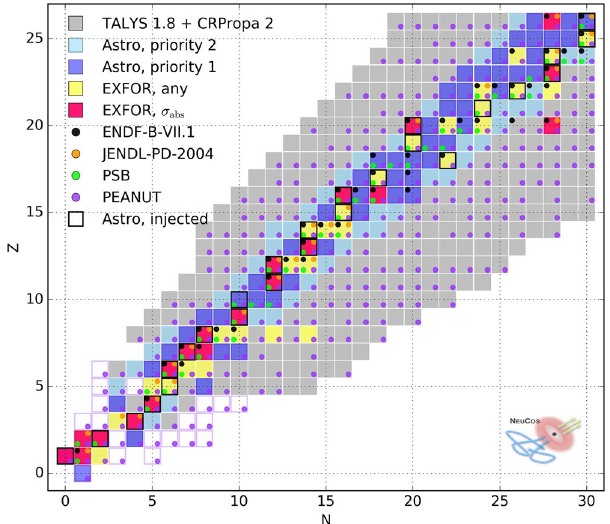
Figure 1. Experimental situation versus astrophysical requirements for nuclear isotopes interesting for cosmic ray astrophysics (gray boxes, from TALYS 22 and CRPropa2 24 ). Experimental measurements (from EXFOR database 32 ) are marked by red (yellow) boxes if the total absorption (any inclusive cross section) has been measured. Theoretical models are marked by dots (ENDF 50 , JENDL 51 , PEANUT 33, 52 , PSB 20 ). Calculations in cosmic ray astrophysics require the total and inclusive cross sections for the blue isotopes. These isotopes have been obtained by recursively following all possible paths from all possible injection elements with different threshold multiplicities (for priorities 1 and 2), see main text for details. Injected isotopes are framed by black rectangles (we inject the most abundant stable isotope for each Z ). Violet framed rectangles refer to very unstable isotopes integrated out in the disintegration